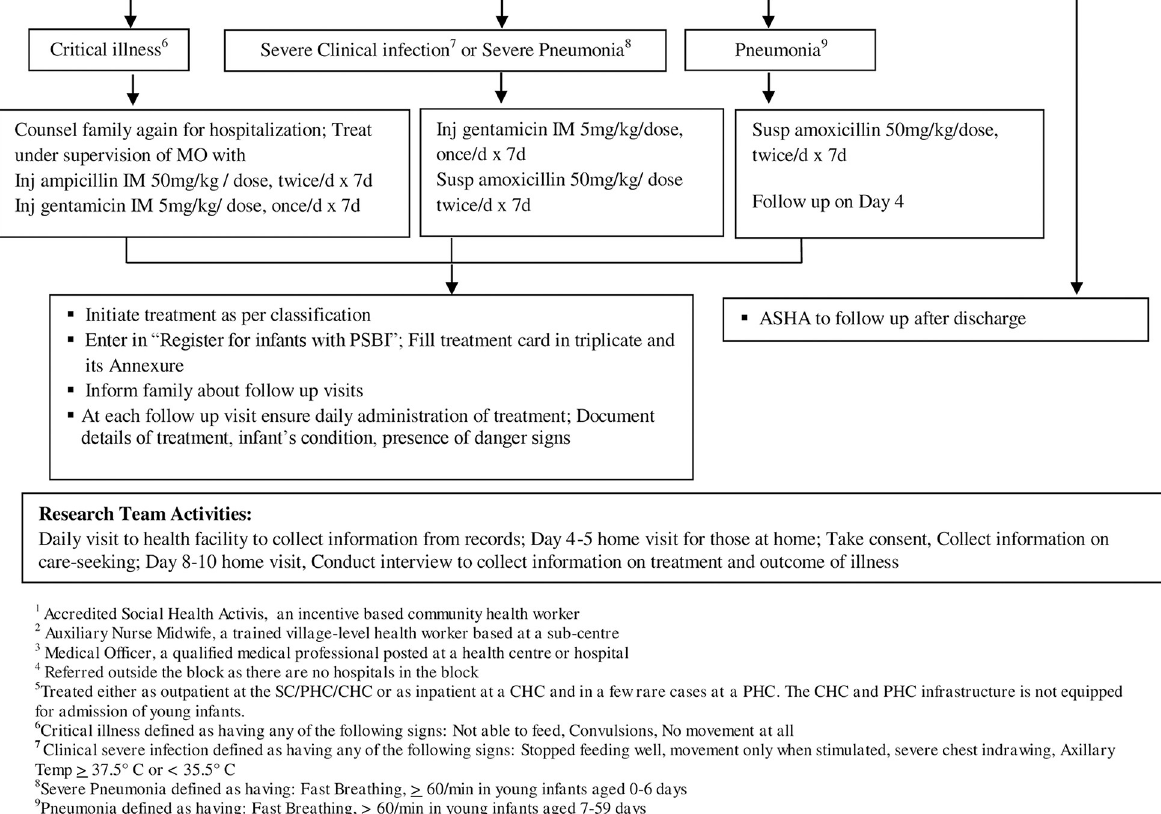
Fig 2. Strategy for management of PSBI in sick young infants where referral is not feasible. https://doi.org/10.1371/journal.pone.0243724.g002 PLOS ONE | https://doi.org/10.1371/journal.pone.0243724 December22,